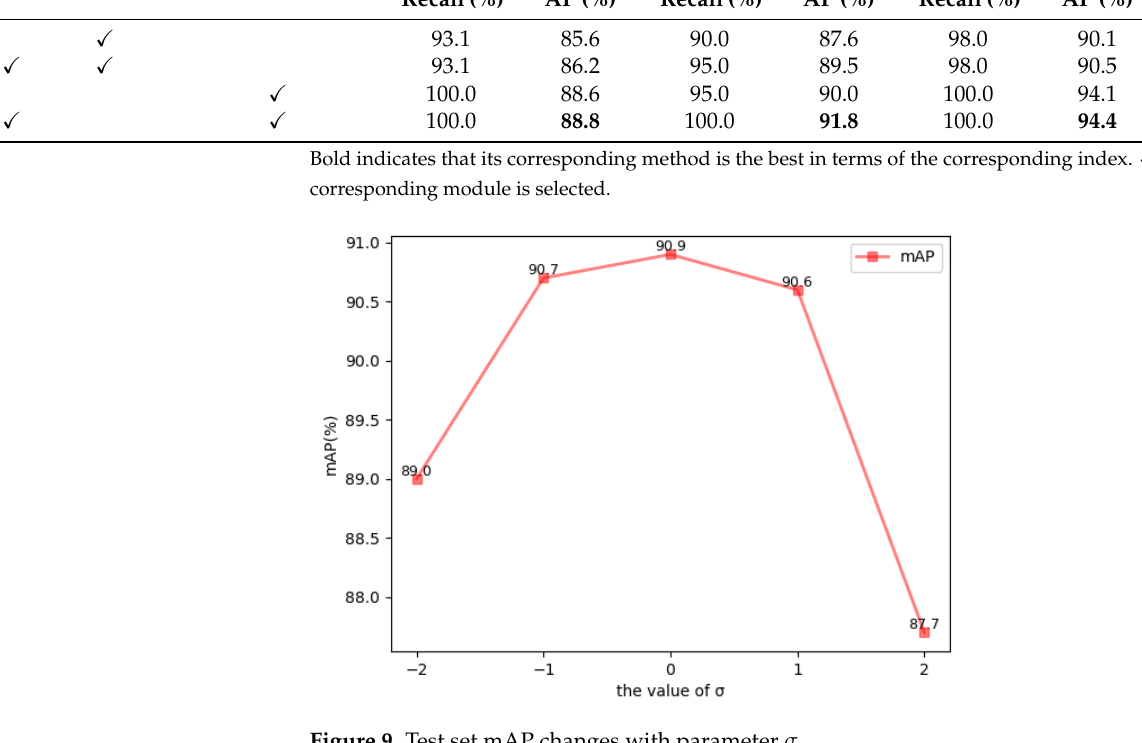
Figure 9. Test set mAP changes with parameter σ .